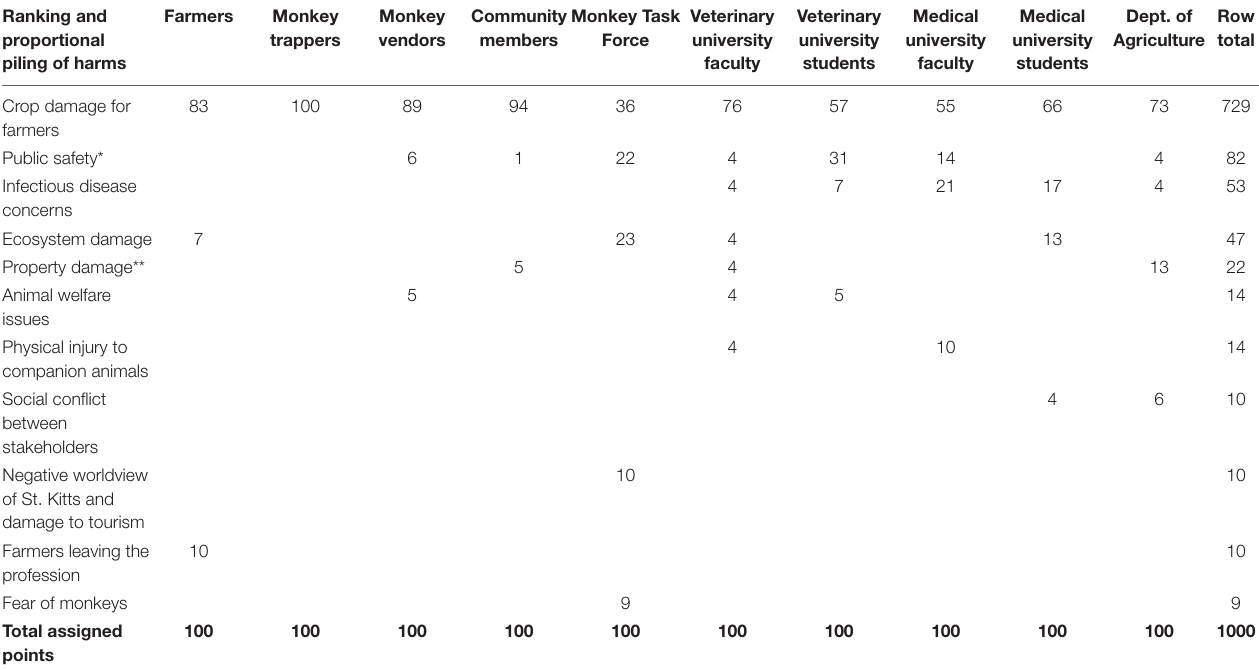
TABLE 6 | Stakeholder ranking and proportional piling of harms within the “monkey problem.” Ranking and Farmers Monkey Monkey proportional trappers piling of harms